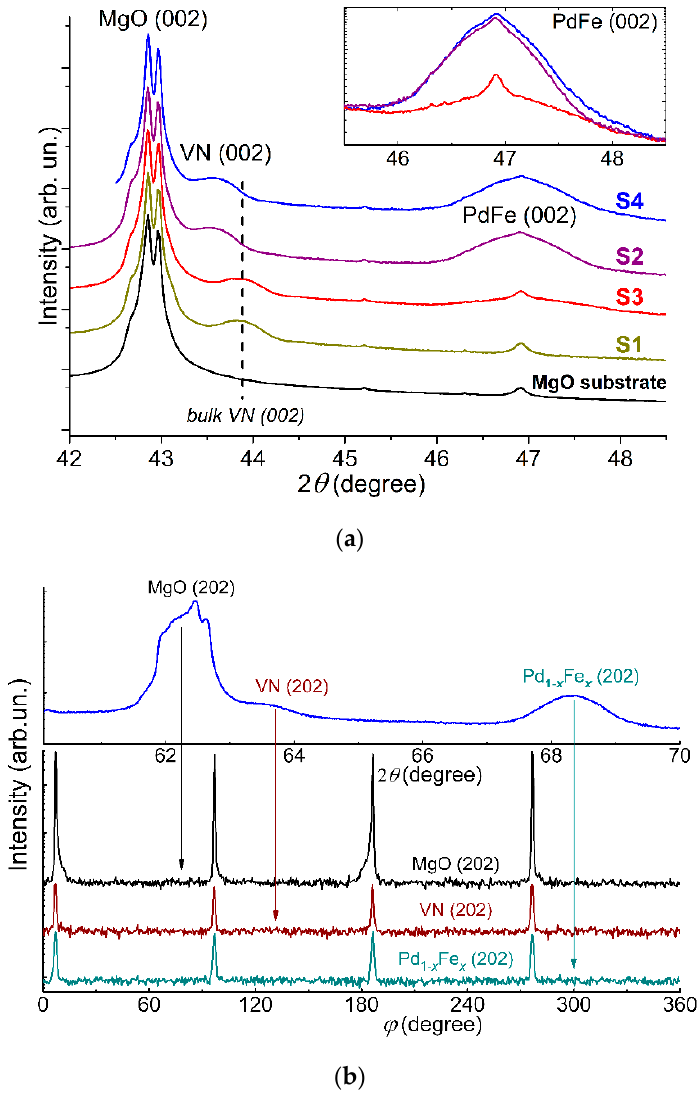
Figure 3. ( a ) X-ray diffractogram ( θ -scan) of Samples S1-S4 and the pristine MgO(001) substrate, recorded before the thin film deposition (see legends). ( b ) X-ray diffraction φ -scans of Sample S4; the Eulerian cradle angle χ was set to 45° to detect the <220> XRD-maxima. The θ -angle values at which the φ -scans were recorded for each material are indicated by vertical arrows.